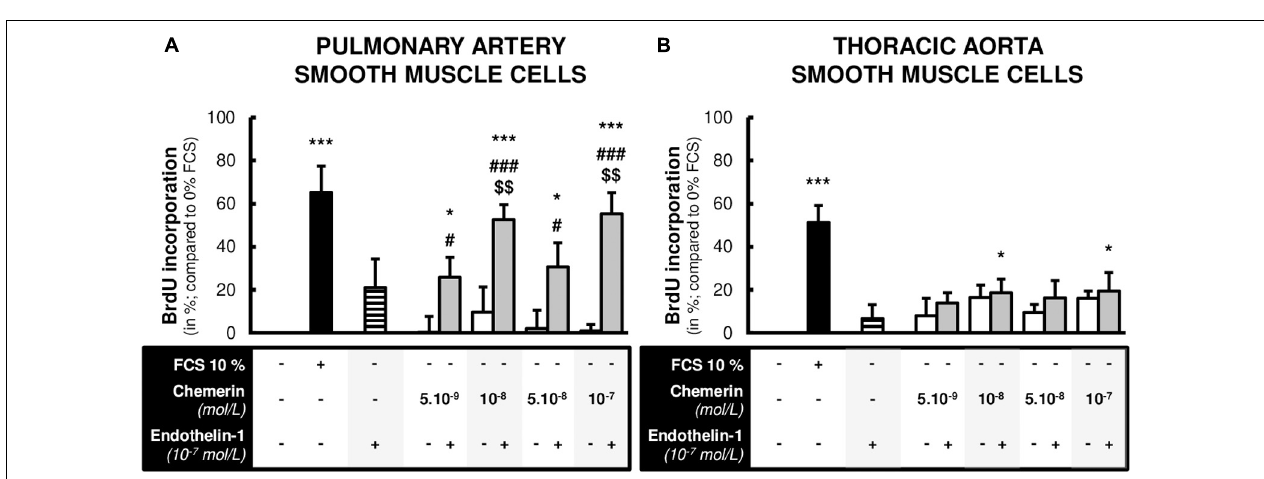
FIGURE 3 | Combined chemerin and endothelin-1 treatment increased the proliferation of pulmonary artery smooth muscle cells. Quantification of 5-bromo-2’-deoxyuridine (BrdU) incorporation in primary cultured pulmonary artery [ (A) , six experiments in total] and thoracic aorta [ (B) , seven experiments in total] smooth muscle cells isolated from Wistar rats ( n = 4), treated or not with endothelin-1 (10 − 7 mol/L) with increasing concentrations of recombinant mouse chemerin (tested from 5.10 − 9 to 10 − 7 mol/L) for 24 h. The proliferative responses were expressed as relative fold increase over the mean value of the proliferative rate of basal condition [corresponding to 0% fetal calf serum (FCS)-treated] in the same type of smooth muscle cells. Results were presented as mean ± SEM. *0.01 < p < 0.05 and *** p < 0.001 compared to corresponding 0% FCS-treated cells; # 0.01 < p < 0.05 and ### p < 0.001 compared to corresponding chemerin-treated cells; $$ 0.001 < p < 0.01 compared to corresponding endothelin-1-treated cells.